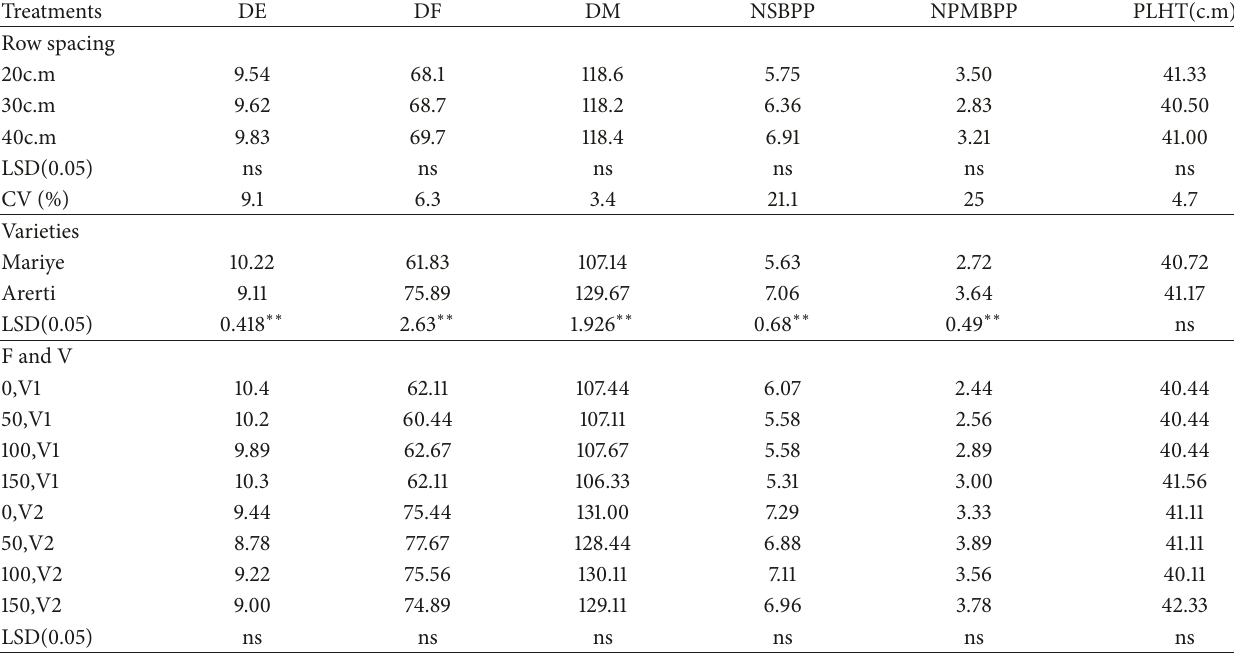
Table 2: Chickpea phenological and growth parameters as influenced by main effect of interrow spacing, variety, and interaction effect of blended fertilizer rates (kg/ha) and varieties.